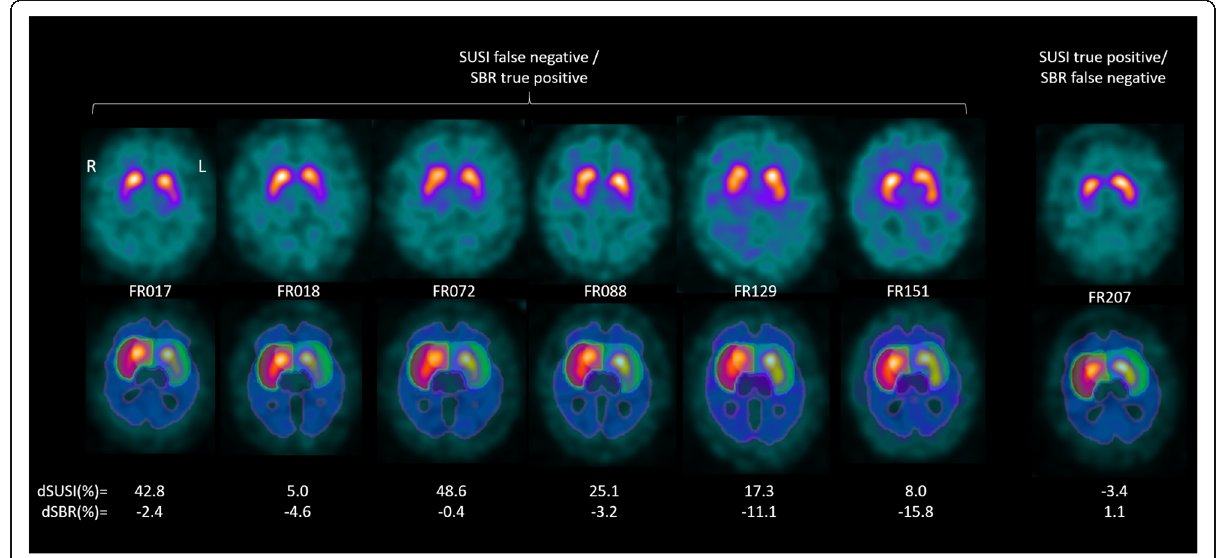
Fig. 3 FP-CIT SPECT images from the mono-site/mono-camera setting with discrepant classification as “ neurodegenerative PS ” or “ non- neurodegenerative PS ” based on the putaminal SUSI computed in patient space versus classification based on the putaminal SBR. The upper row shows transversal slices through the striatum in patient space. The lower row shows the same transversal slice with the transformed mask of caudate, putamen and the reference region overlaid. dSUSI = 100*(individual SUSI – SUSI cutoff) / SUSI cutoff, dSBR = 100*(individual SBR – SBR cutoff) / SBR